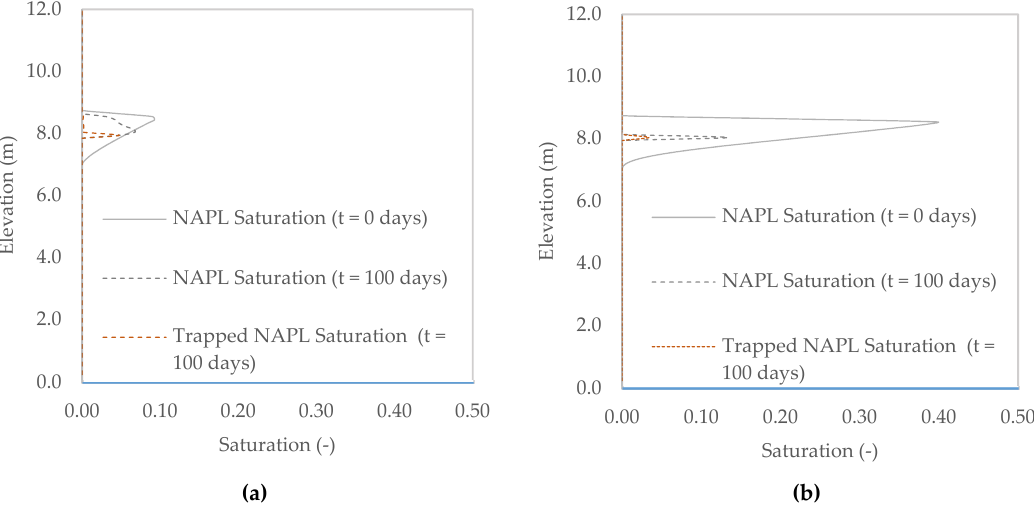
Figure 15. Free and entrapped LNAPL after 100 days of extraction: ( a ) silty sand; and ( b ) oxisol.